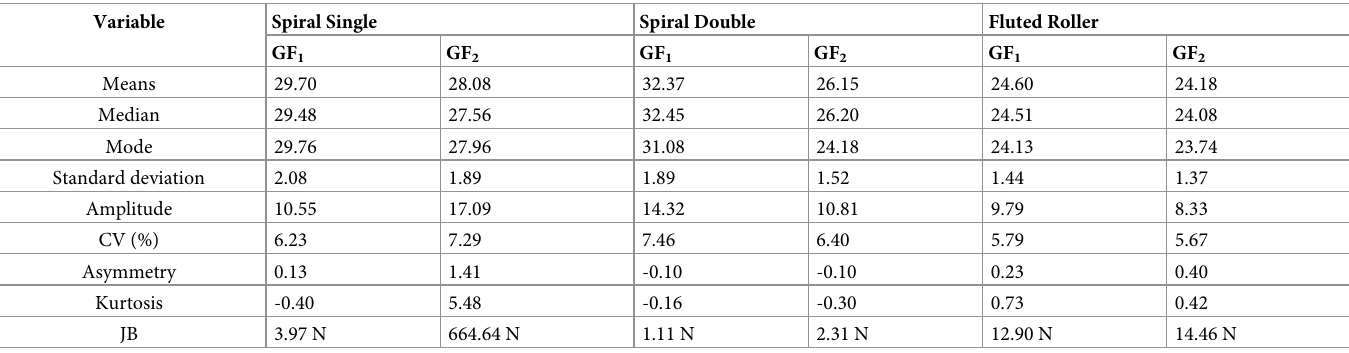
Table 6. Descriptive statistics of outflow data of granular fertilizers using different fertilizer spreaders at a linear speed of 1.94 m s -1 .